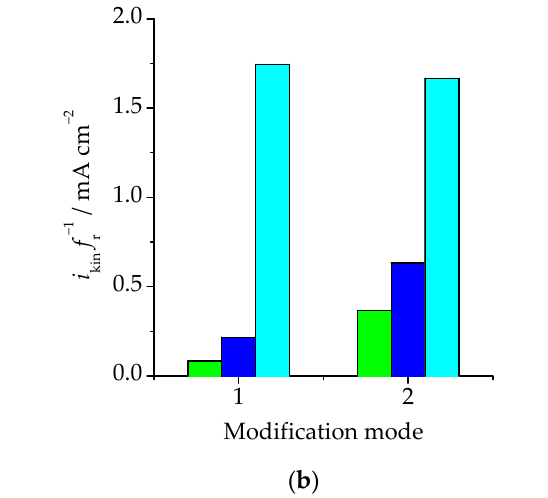
Figure 8. The rate of the kinetic stage of electro-oxidation of HCOOH on the anodically modified Cu 85 Pd 15 alloy, found ( a )—without, and ( b )—with accounting for the surface development of the electrode depending on the potential of anodic oxidation of formic acid and the mode of anodic modification of the alloy: (1)— E mod = 630 mV, q mod = 24 mC·cm − 2 ; (2)— E mod = 630 mV, q mod = 480 mC·cm − 2 .